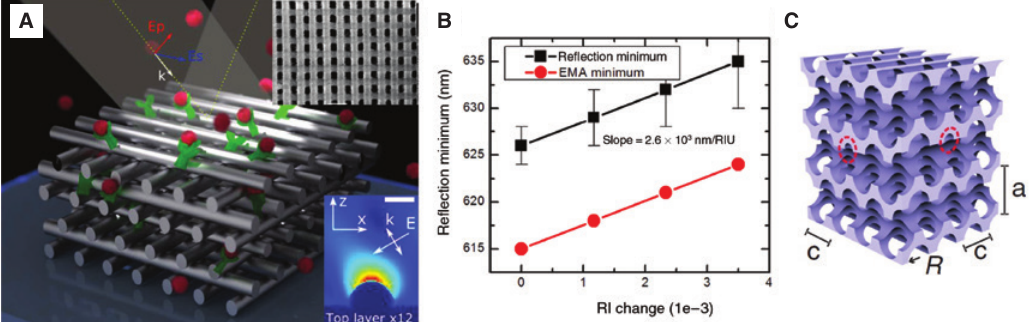
Figure 32: 3D plasmonic metamaterials and PBG